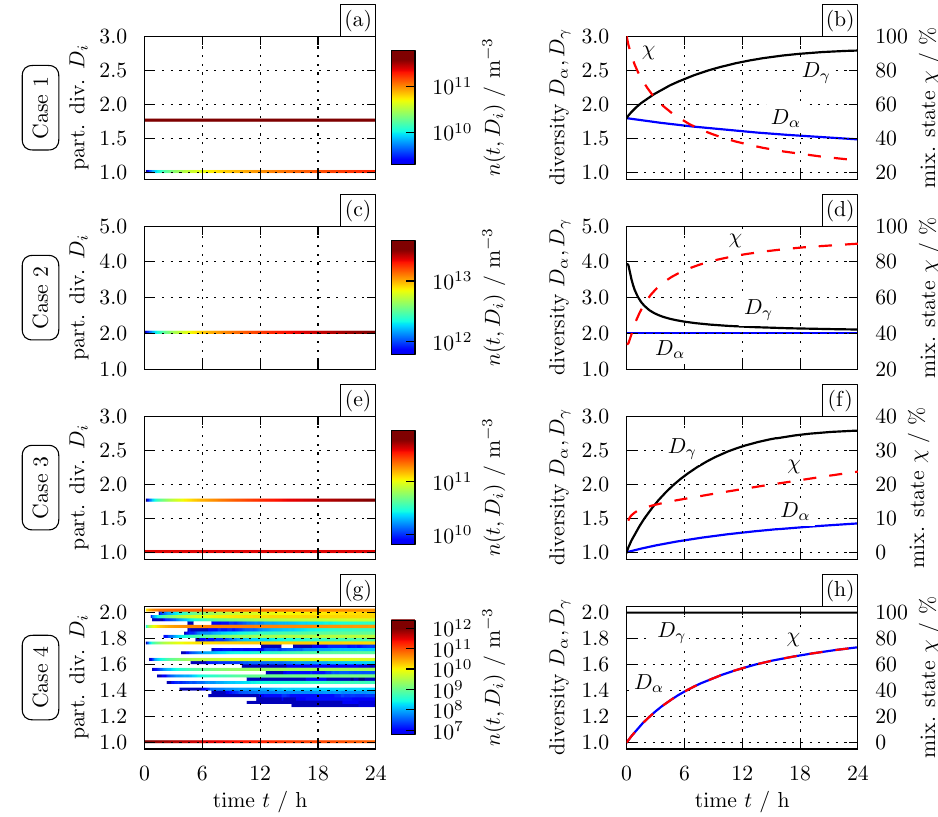
Fig. 3. Diversity and mixing state evolution for archetypal cases. Left column: Distributions of per-particle diversity D i as a function of time. Right column: time series of average particle diversity D α , population diversity D γ , and the mixing state index χ . Note that the left axis shows D α and D γ , and the right axis shows χ . The rows correspond to Cases 1 to 4 as defined in Table 6.